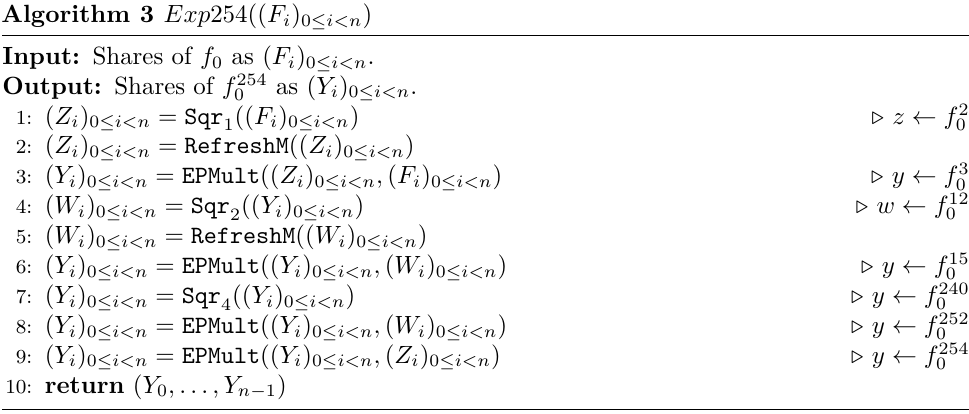
Algorithm 3 Exp 254(( F i ) 0 ≤ i<n